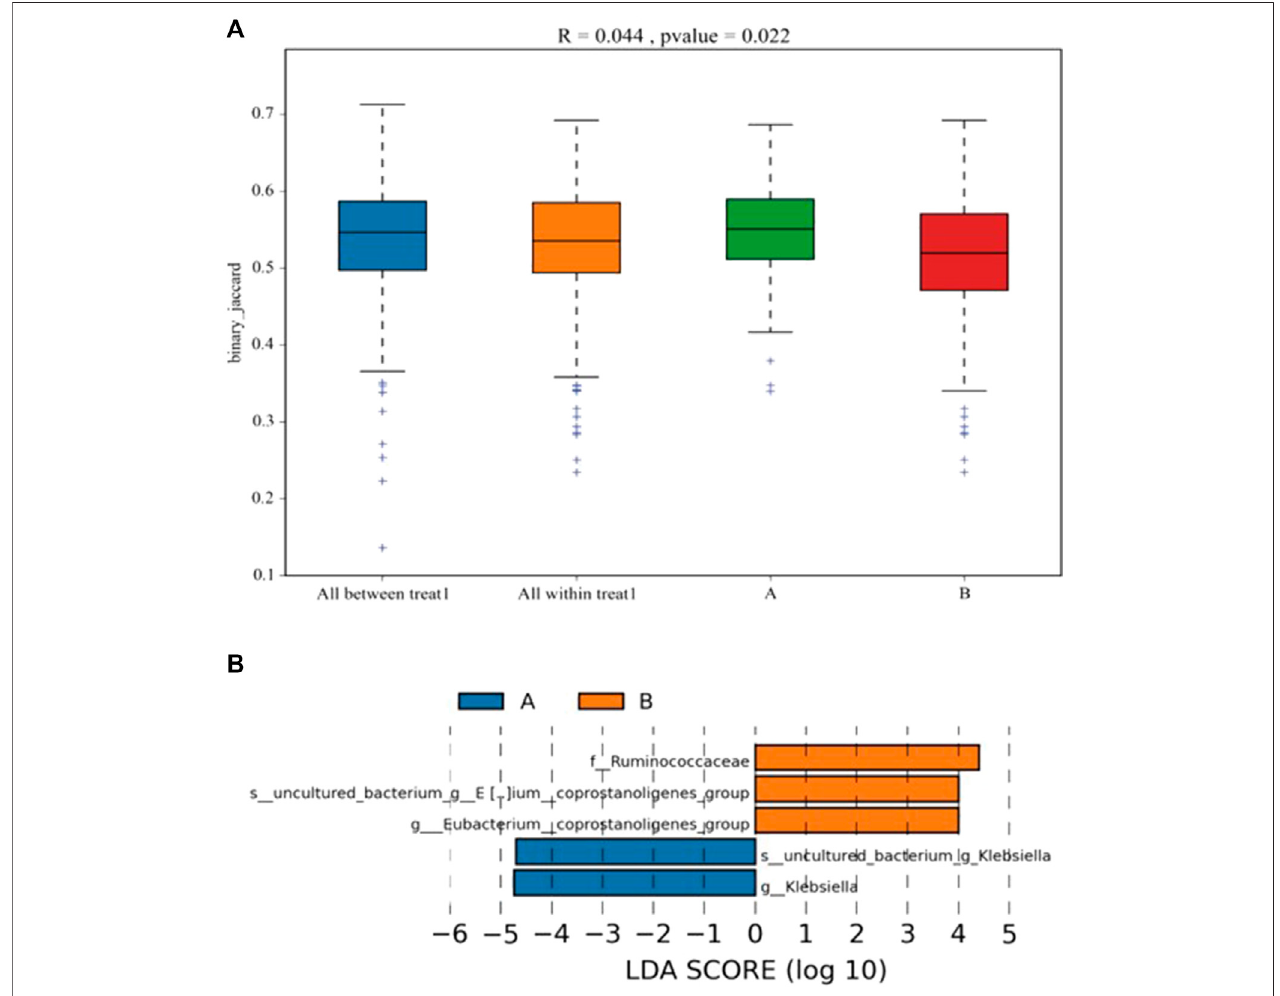
FIGURE 3 | Analysis of the differential microbial in fecal. (A) the differentia in two groups (ANOSIM). (B) LDA score displays the different microbiota ( p < 0.05). Orange represents increase, and blue represents decrease. A: SAE group; B: nonSAE group.